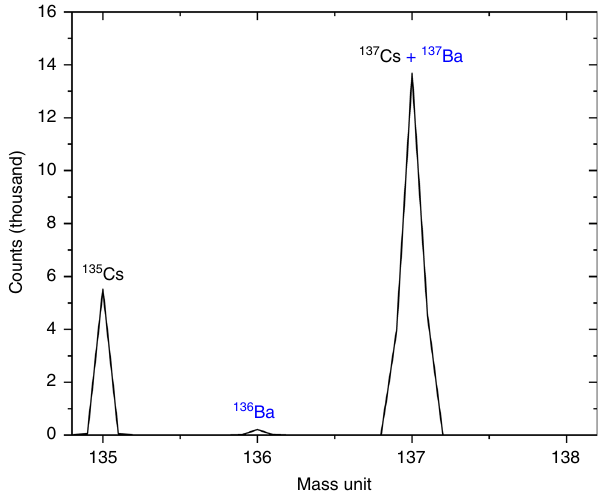
Fig. 5 Cs and Ba mass spectra: SIMS mass spectra (positive bias) between 135 and 138 amu, derived from the Cs-rich region evidenced to exist within the CF-01 bulk particle (identi fi ed in Fig. 3)